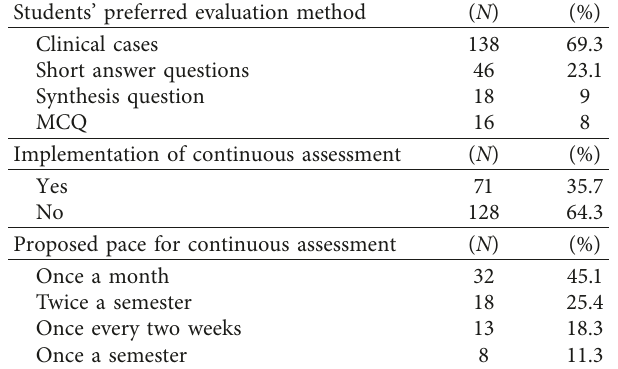
Table 3: Criteria measured through clinical assessment by